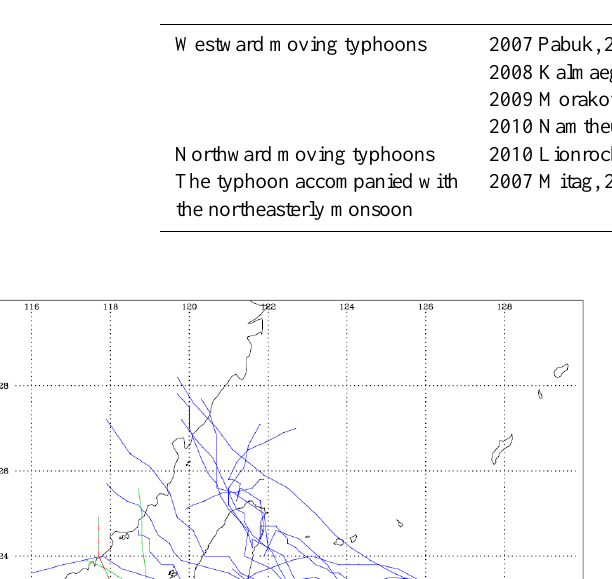
Table 2. The typhoon list for the independent cases.